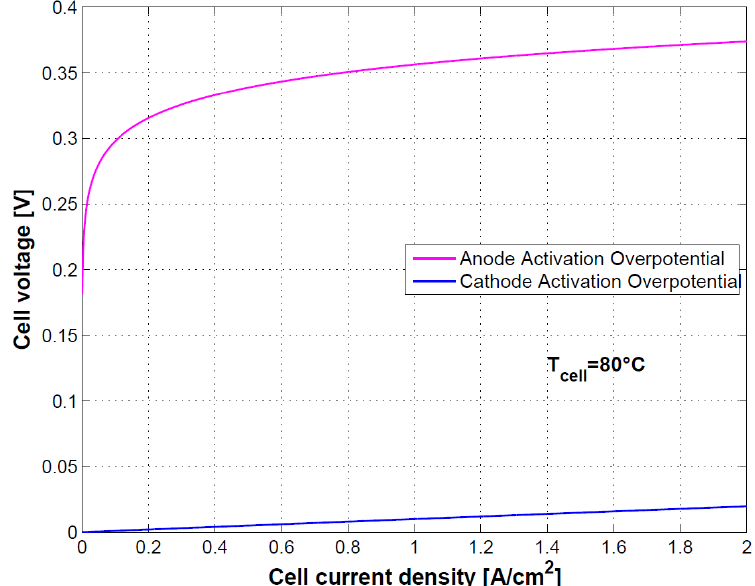
Figure 7. Anode and cathode activation overpotentials.